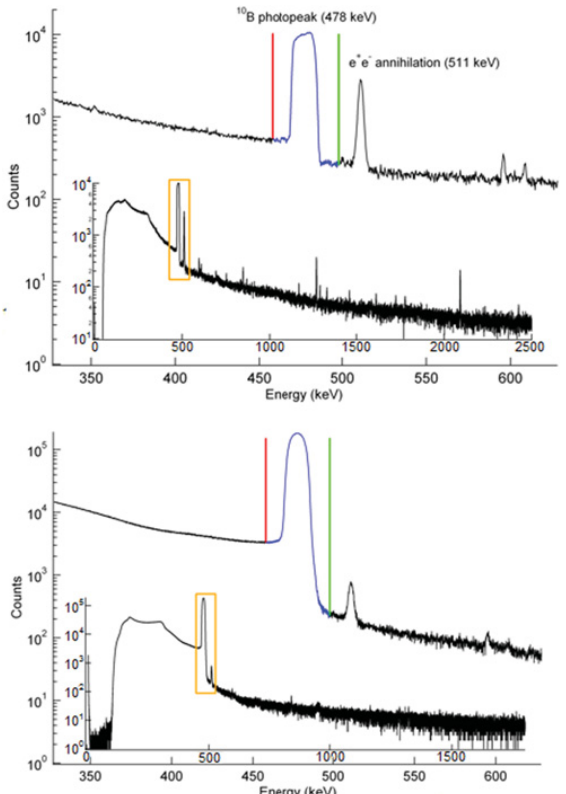
Figure 2. Spectra from the Alpha-Gamma HPGe detectors during thin target (top) and thick target (bottom) measurement runs. The boxed region of each spectrum is maginfied, with the lower and upper SCA thresholds